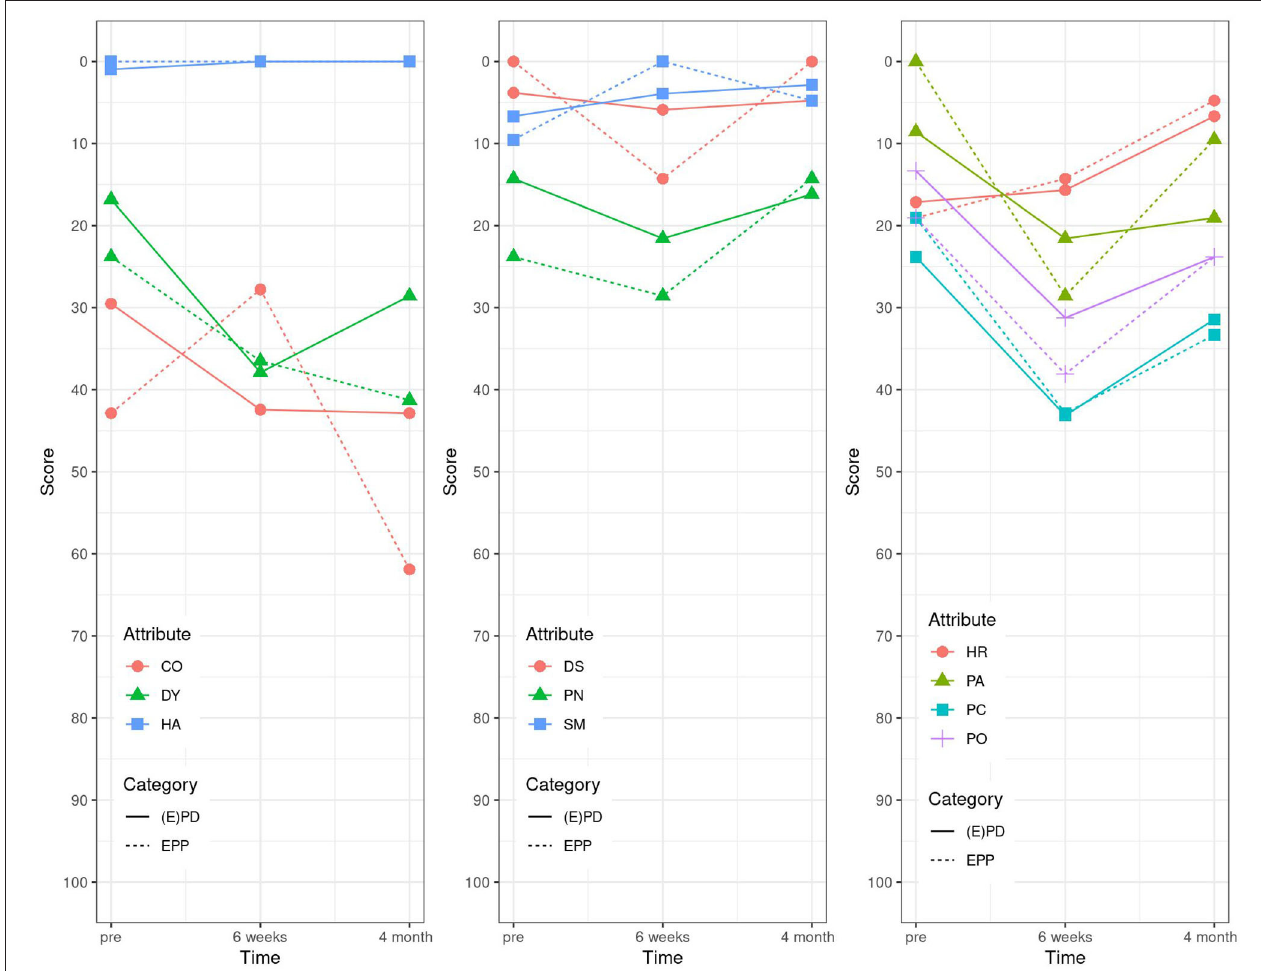
FIGURE 4 | EORTC LC 13 (1994): high score for the scales and single items represents a high level of problems/symptomatology. DY, dyspnea; CO, coughing; HA, hemoptysis; SM, sore mouth; DS, dysphagia; PN, peripheral neuropathy; HR, alopecia; PC, pain in chest; PA, pain in arm/shoulder; PO, pain in other